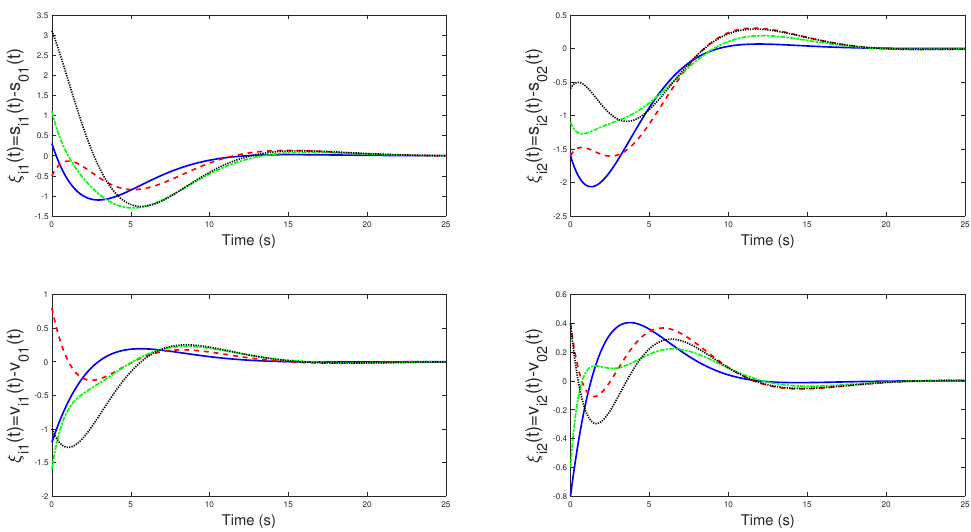
Figure 3. The tracking error responses of the displacement and velocity for all UAVs under conven- tional